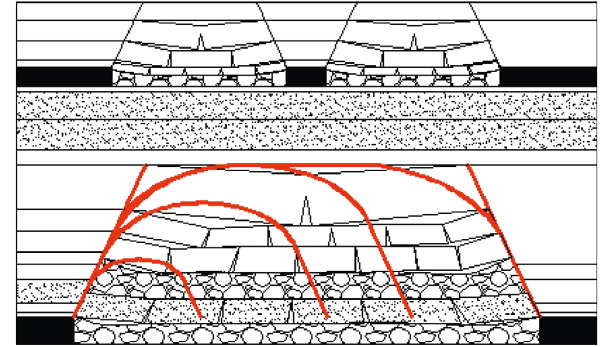
Figure 8: The relationship between upper gob and lower gob under the condition of thick layer strata.